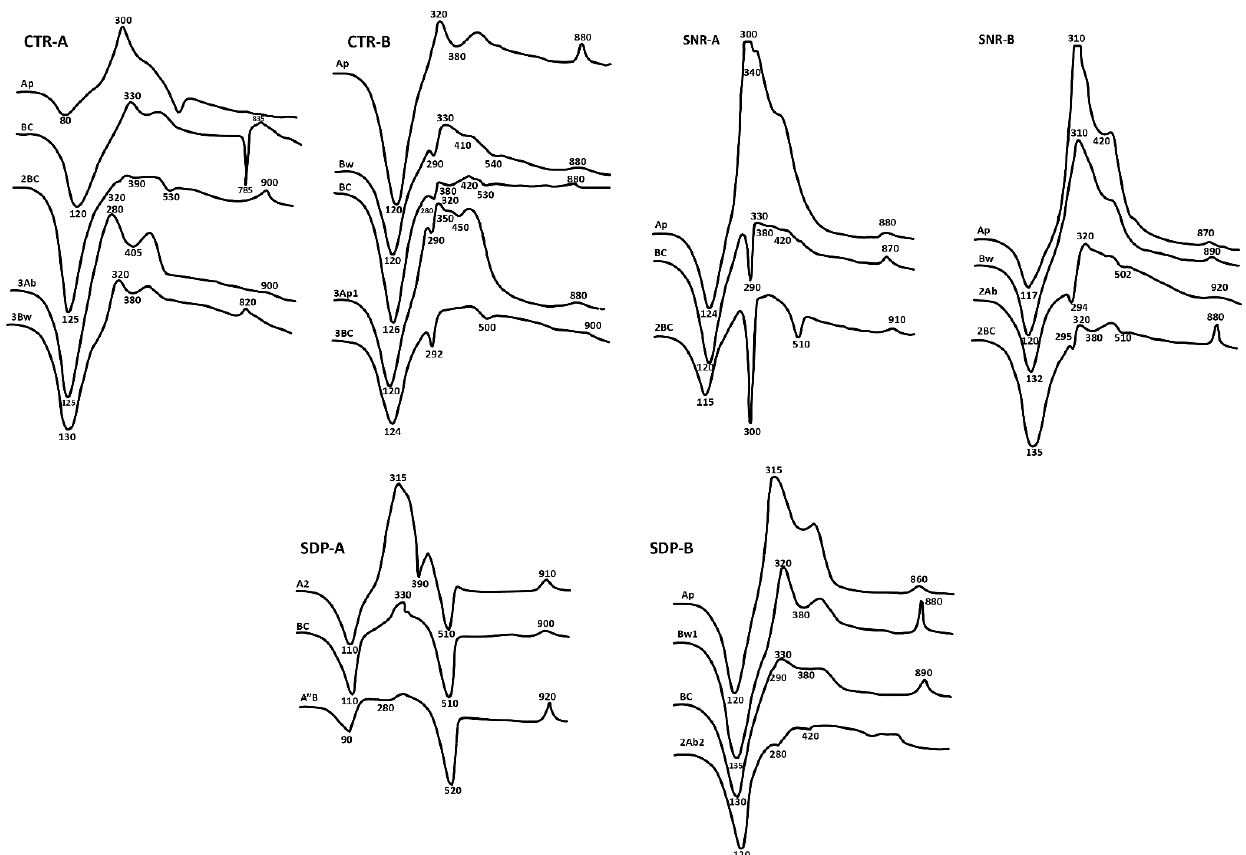
Figure 3. Differential thermal analysis (DTA) curves of clay fractions of sampled Andisol profiles.